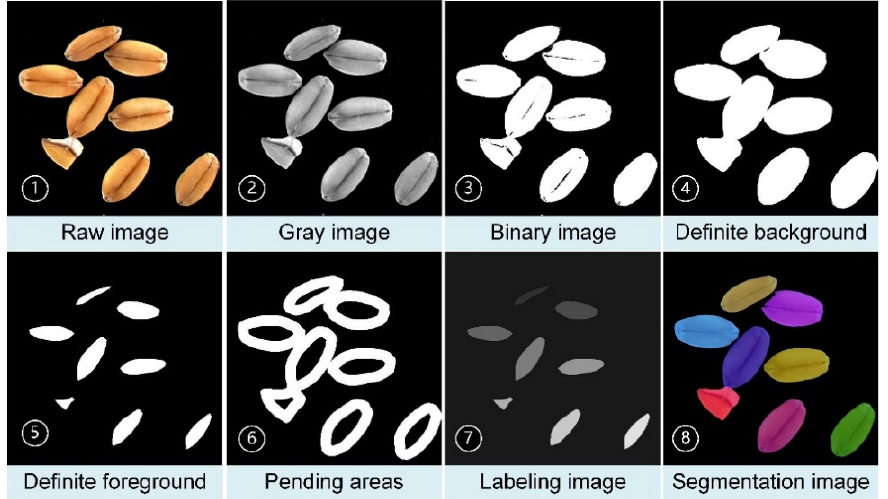
Figure 2. The operating flow by MWS algorithm.